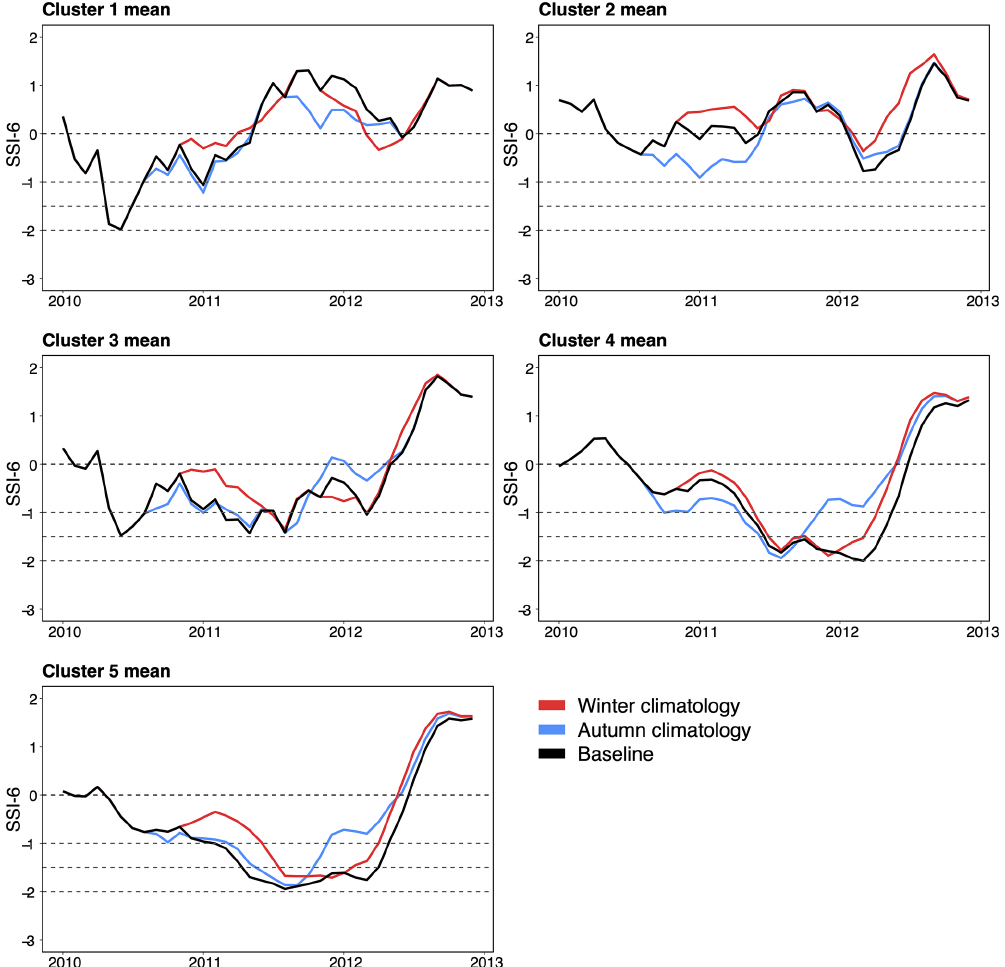
Figure 5. Cluster mean SSI-6 for the storylines of seasonal contributions with winter 2010/2011 (red) and with autumn 2010 and 2011 (blue) replaced by daily climatological values. See Figs. S5 and S6 for the equivalent figure for SSI-12 and SSI-24.